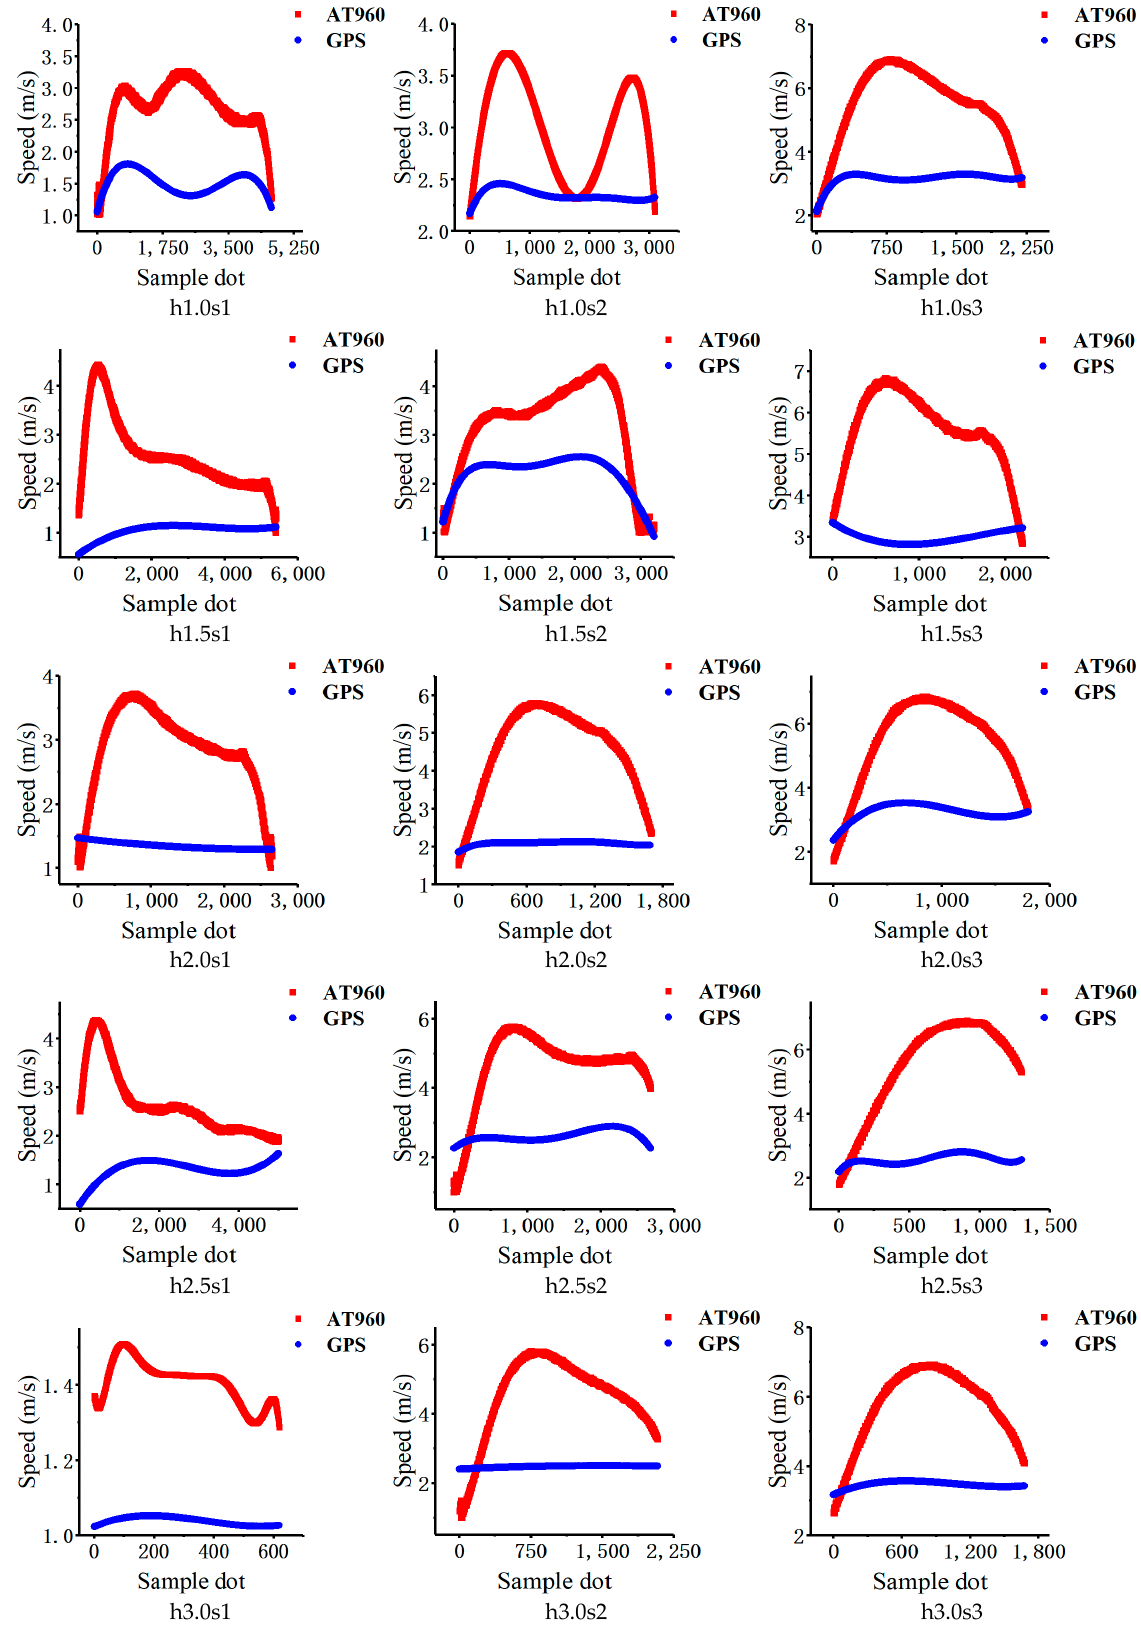
Figure 9. Flight speed.